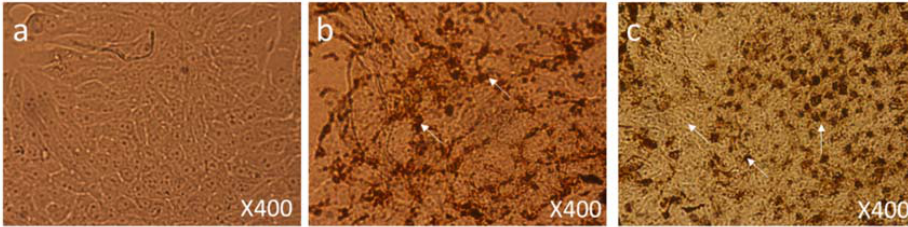
Figure 8. Cell Morphology: The MCF ‐ 7 cells showing morphology ( a ) control (nontreated), ( b ) treated with FMSP ‐ nanoparticles (12.5 μ g/mL) for 6 h showing high level of cell death, nuclear disintegration, nuclear augmentation (arrows), ( c ) treated with FMSP ‐ nanoparticles (12.5 μ g/mL) for 24 h showing drastic increase in cell death, nuclear disintegration, nuclear augmentation (arrows) after 24 h of post ‐ FMSP ‐ nanoparticle treatment. 400× magnification.